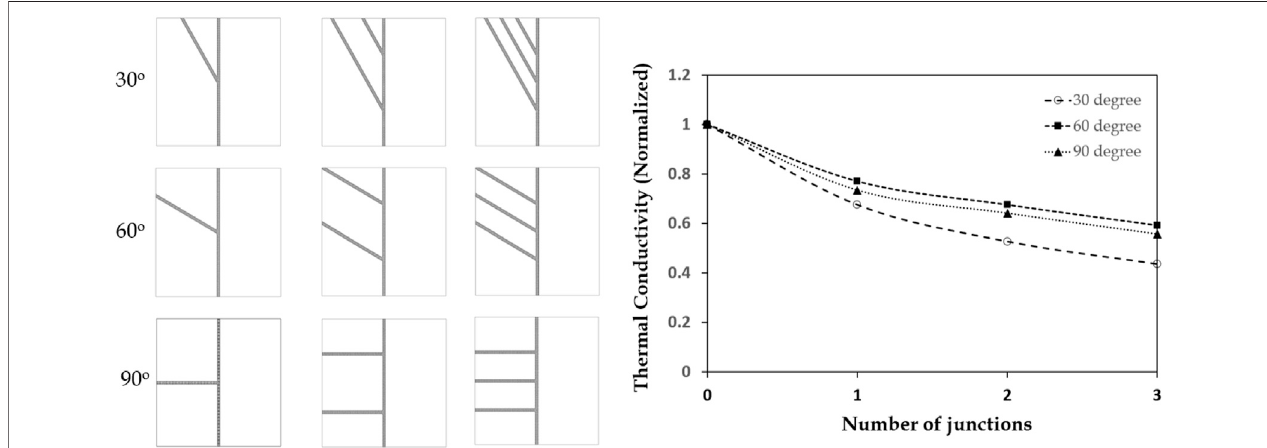
FIGURE8| Effectofjunctionpopulationonthermaltransportofdifferentangle3T-Junctions.The fi guresontheleftindicatesninejunctioncon fi gurationswithrows representing 30 o , 60 o , and 90 o junctions, and columns representing one, two and three 3T-Junctions along the vertical direction. The graph on the right represents the thermal conductivity of the junction con fi gurations normalized with respect to pristine SWCNT having the same vertical lengths.